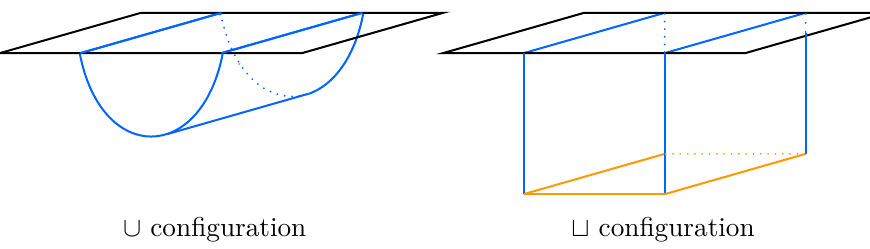
Figure 3. The two possible and competing configurations of the RT surface we have to consider when computing entanglement entropies of strips: for small widths of the strip, a “connected” configuration ∪ , which does not reach the bottom of the geometry (left), competes with the “dis- connected” configuration t , which reaches the end-of-space